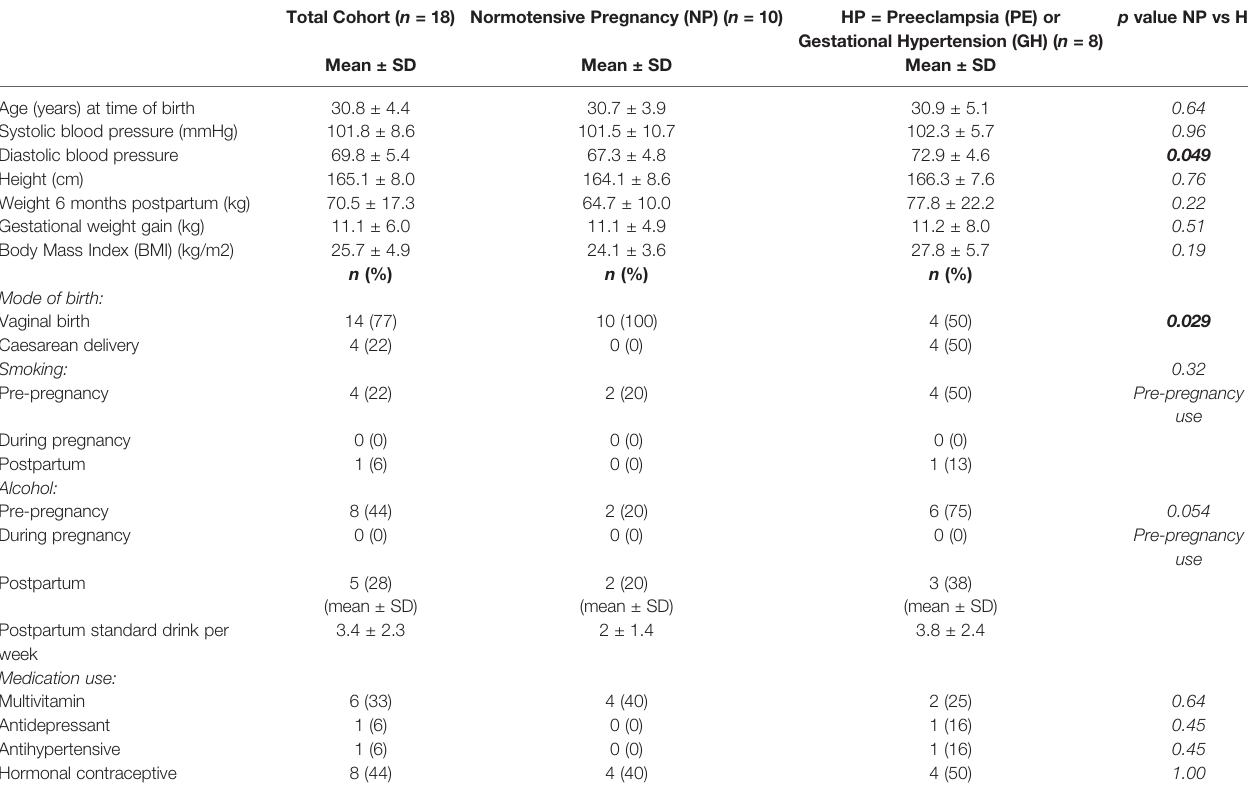
TABLE 1 | Maternal